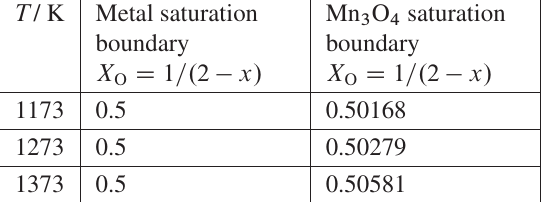
Table 1. Stability field of Mn 1 (cid:3) x O.